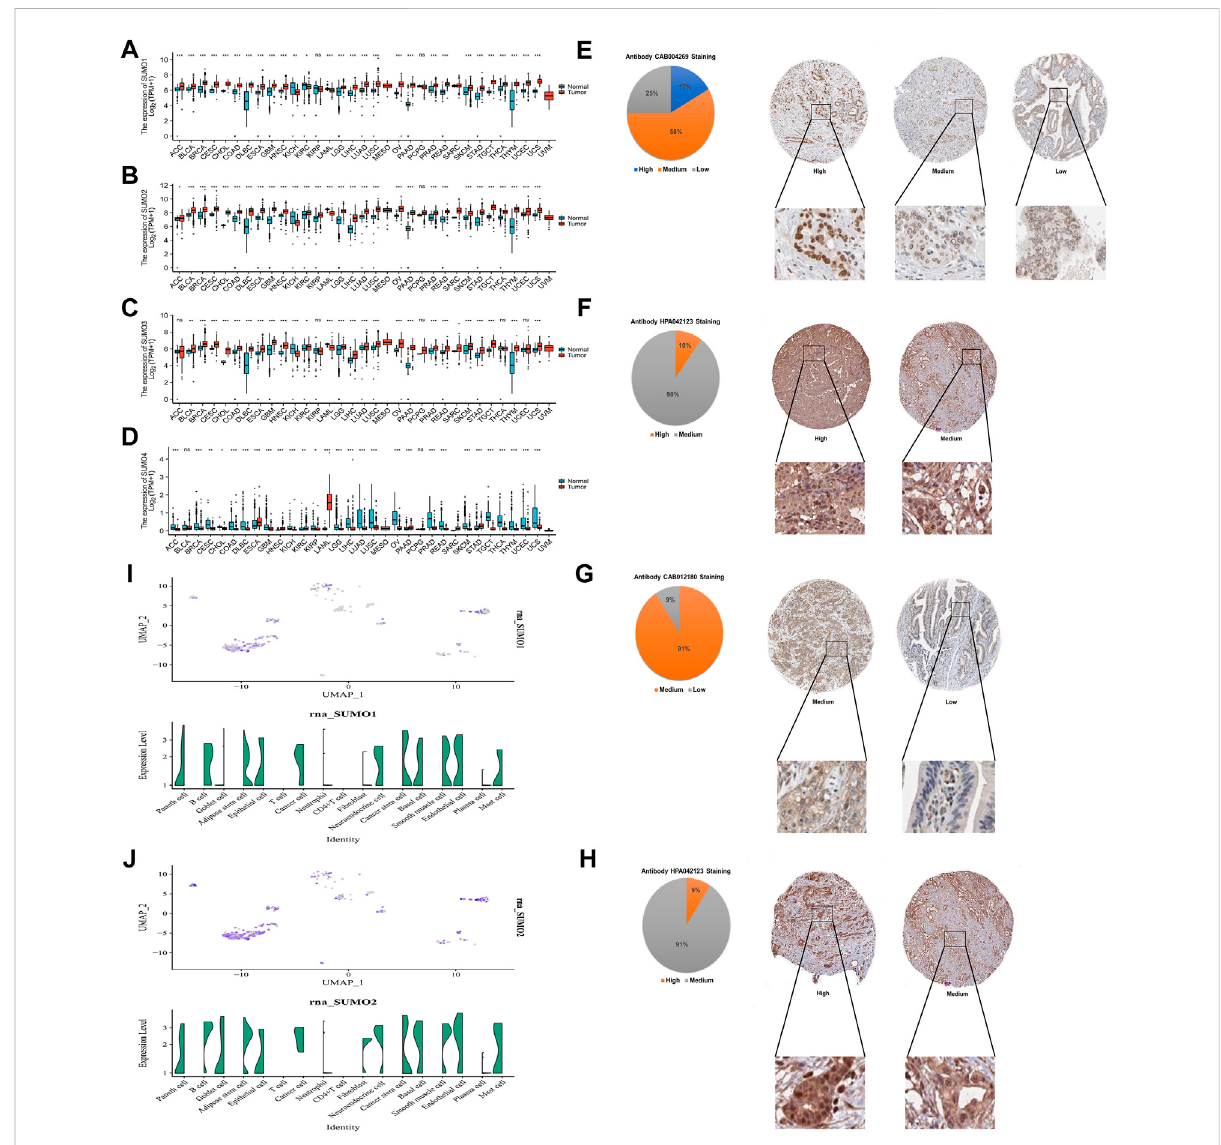
FIGURE 1 Expression characteristics of SUMO family at the mRNA level in pan-cancer and the protein level in PAAD, and expression characteristics of SUMO1/2 at the single-cell level in PAAD. (A) The mRNA level of SUMO1; (B) The mRNA level of SUMO2; (C) The mRNA level of SUMO3; (D) The mRNA level of SUMO4. ns, p ≥ 0.05; *, p < 0.05; **, p < 0.01; ***, p < 0.001; (E) The protein level of SUMO1; (F) The protein level of SUMO2; (G) The protein level of SUMO3; (H) The protein level of SUMO4; (I) The single-cell level of SUMO1; (J) The single-cell level of